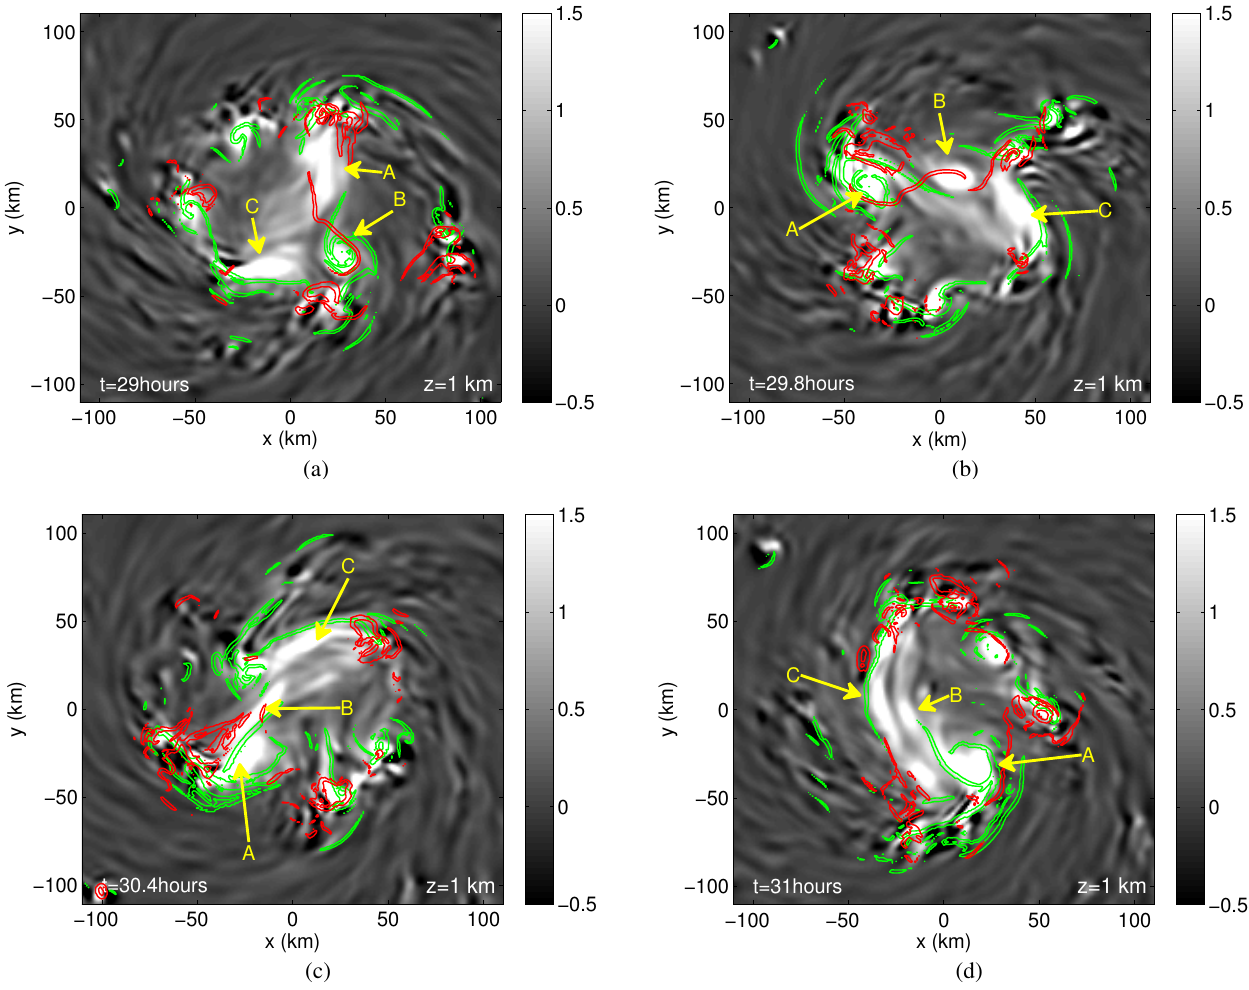
Fig. 11. An example of vortex interaction during the simulated intensification process. The times shown are 29 hours (a), 29.8 hours (b), 30.4 hours (c), and 31 hours (d). Arrows point to a subset of interacting vortices discussed in Section 4.2. The intense vorticity regions, attracting Ψ -LCSs (green), repelling Ψ -LCSs (red), are overlaid on the vorticity field ( ζ × 10 − 3 s − 1 , black and white shading).